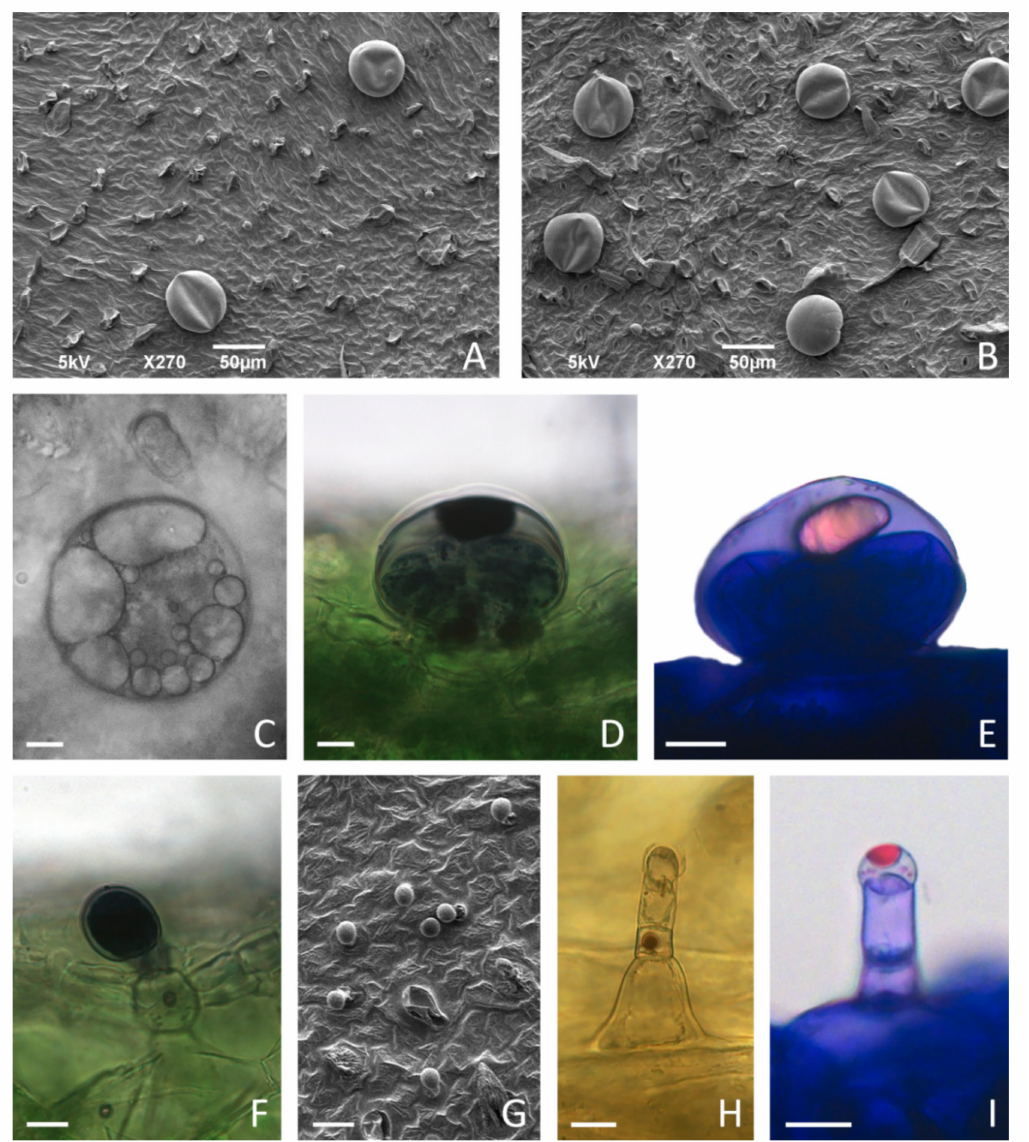
Figure 7. Glandular trichome morphotypes on the leaves of in vitro cultured Clinopodium pulegium . SEM micrographs of adaxial ( A , G ) and abaxial ( B ) surface of leaves of plants cultured on medium supplemented with 2% sucrose. ( C – E ) Peltate trichomes on leaves of plants cultured on medium supplemented with 3% sucrose, consisting of a basal cell embedded in the epidermis, a short unicel- lular stalk and a large round multicellular head comprising eight secretory cells; large amounts of secretory product present within subcuticular space ( C ) stained positively with NADI reagent for terpenoids ( D ) and with Nile Blue A for essential oils ( E ). ( F ) Procumbent type I capitate trichomes (C1), consisting of a basal cell with a short cutinized stalk and unicellular ellipsoidal head, showed positive NADI reaction of head and stalk cells. ( G – I ) Type II capitate trichomes (C2), consisting of a conical basal cell, uni- to bicellular stalk and elongated unicellular head; C2 trichomes are particularly numerous on adaxial leaf surface ( G ), positioned upright ( H ), with apical secretory cell developing subcuticular space filled with secretory droplets positive for essential oils after staining with Nile Blue A ( I ). Scale bars: 50 µ m ( A , B ); 20 µ m ( G ); 10 µ m ( C – F ), ( H – I